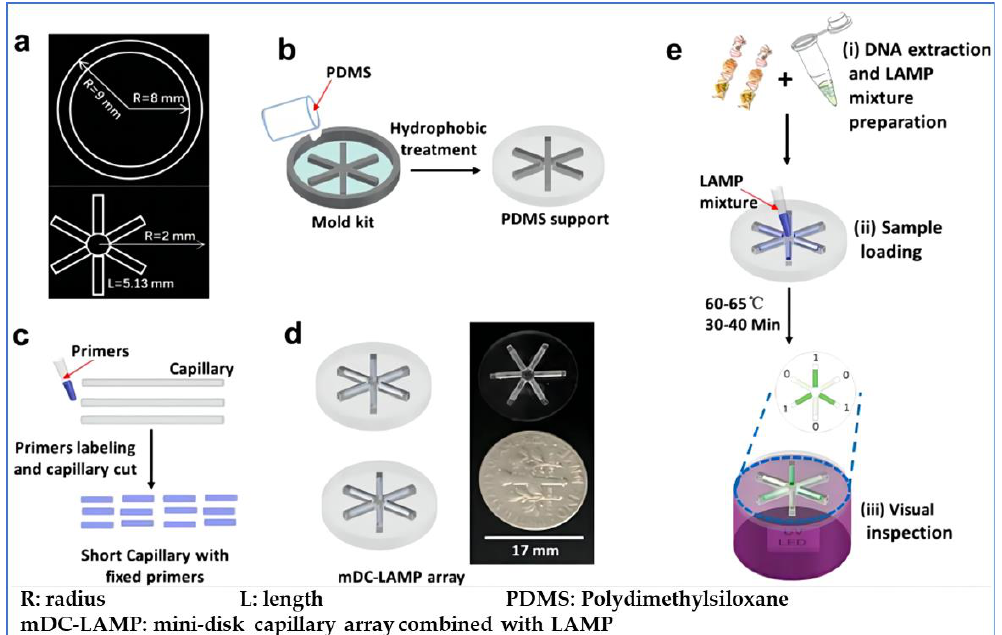
Figure 3. A LAMP-based visualized mini-disk capillary for in field detection [21]. Schematic diagram of the mold kit ( a ); Combination of the circle mold and the actinomorphic star mold for producing the precast PDMS support with hydrophobic treatment ( b ); Short capillaries containing specific LAMP primer sets are cut short for mDC-LAMP array assembly ( c ); Assembled mDC-LAMP array ( d ); Schematic illustration of mDC-LAMP analysis ( e ).